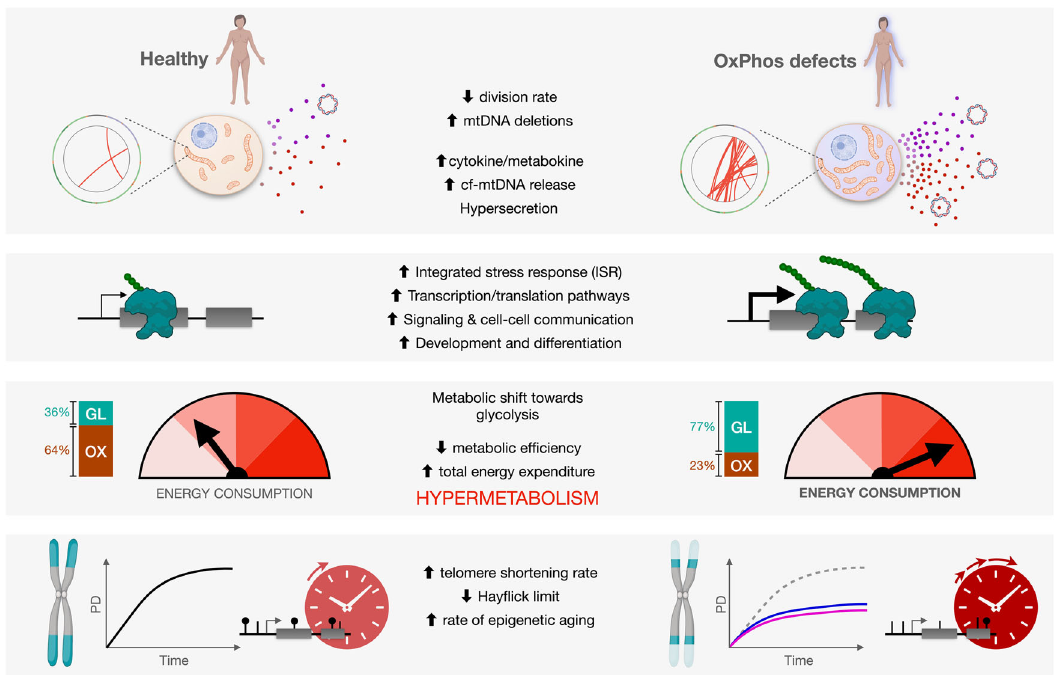
Fig. 9 Conceptual model including potential sources of hypermetabolism in cells and patients with mitochondrial diseases. OxPhos defects trigger mtDNA instability and cell-autonomous stress responses associated with the hypersecretory phenotype, recapitulating fi ndings in plasma of patients with elevated metabokine and cell-free mitochondrial DNA (cf-mtDNA) levels. These responses are linked to the upregulation of multiple energy-dependent transcriptional programs, including the integrated stress response (ISR). We propose that these processes collectively increase energy consumption, leading to hypermetabolism in patient-derived fi broblasts, and physiological hypermetabolism in affected patients. In dividing human fi broblasts, hypermetabolism-causing OxPhos defects curtail lifespan and accelerate canonical cellular senescence and aging markers, namely telomere length, epigenetic aging, as well as secreted and transcriptional